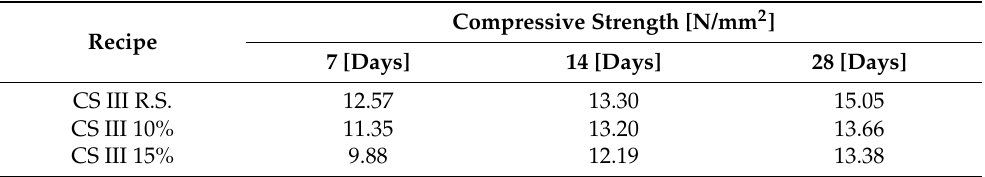
Table 8. Results for compressive strength on hardened mortars.